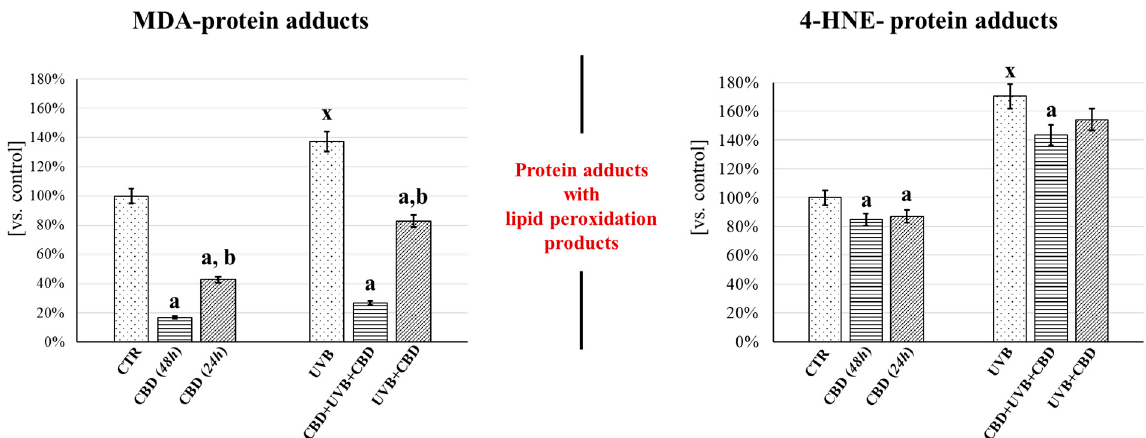
Figure 6. Effect of CBD and UVB radiation on the formation of adducts of proteins with lipid peroxidation products (MDA and 4-HNE) in keratinocyte membrane fractions. Keratinocytes were prepared as follows: [CTR]—cultured with standard medium; [CBD(48 h)]‚—cultured in medium containing 4 µ M CBD for 48 h; [CBD(24 h)]—cultured in medium containing 4 µ M CBD for 24 h; [UVB]—irradiated with UVB (312 nm) at 60 mJ/cm 2 on standard medium, [CBD + UVB + CBD]—cultured with medium containing 4 μ M CBD 24 h before and after UVB irradiation; [UVB + CBD]—cultured with medium containing 4 μ M CBD 24 h after UVB irradiation. Mean values ± SD of five independent samples and statistically significant differences for p ≤ 0.05 are presented: a—differences vs. CTR or UVB; b—differences vs. CBD(48 h) or CBD + UVB + CBD; x—differences between UVB and CTR group.